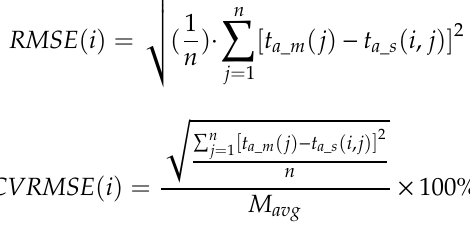
Figure 7. Simulated indoor air temperature compared to the measured data during occupied hours, referencing occupants count.